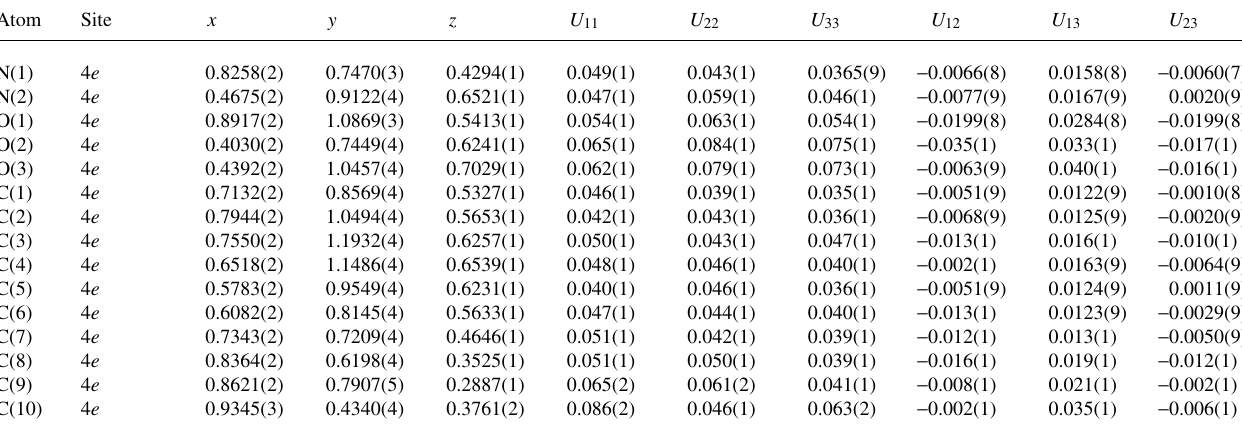
Table 3. Atomic coordinates and displacement parameters (in Å 2 )